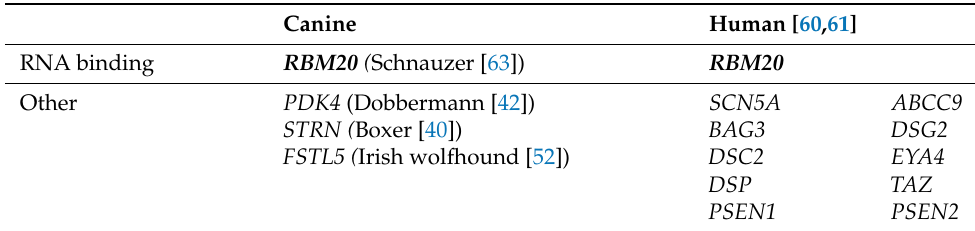
Table 1. Cont. Canine Human [60,61] RNA